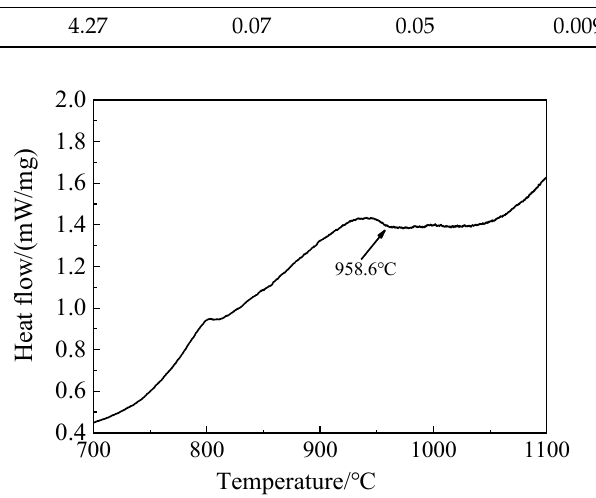
Figure 1. DSC curves of TC4 alloy.